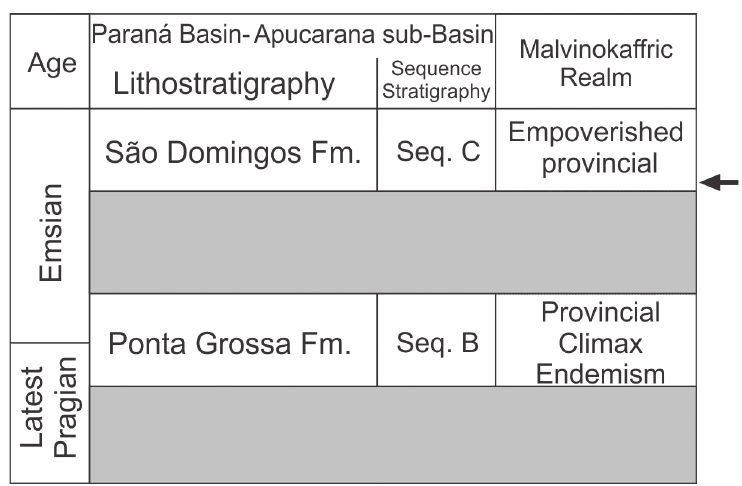
Figure 3 - Chronostratigraphic scheme for the Early Devonian interval in the Paraná Basin, Brazil (modified from Grahn et al. 2013). The arrow indicates the provenance of the shark fin remains described